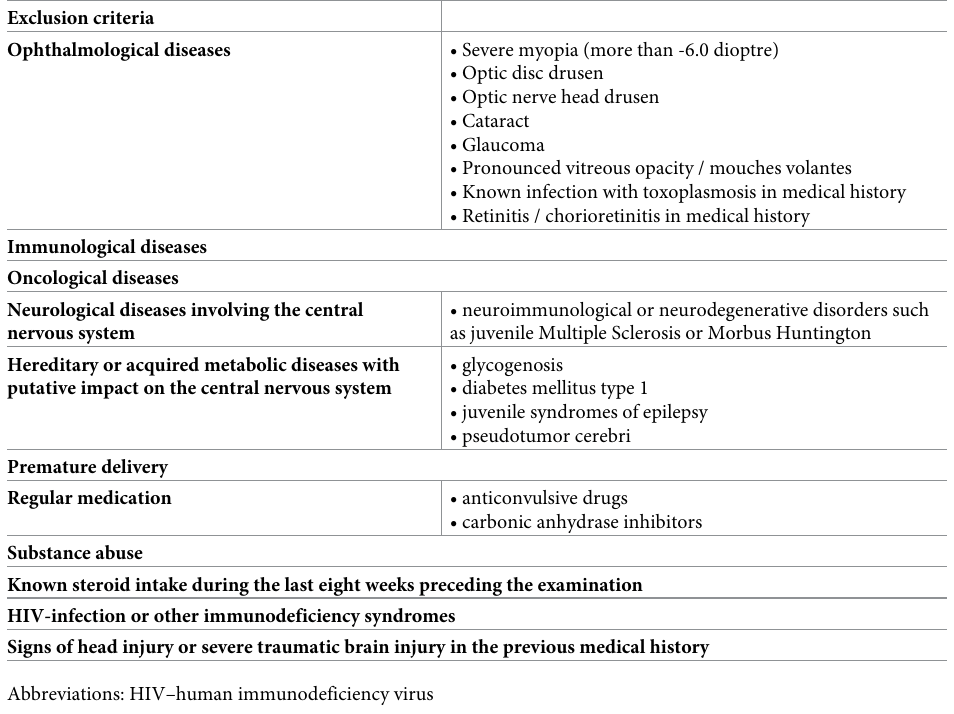
Table 1. Exclusion